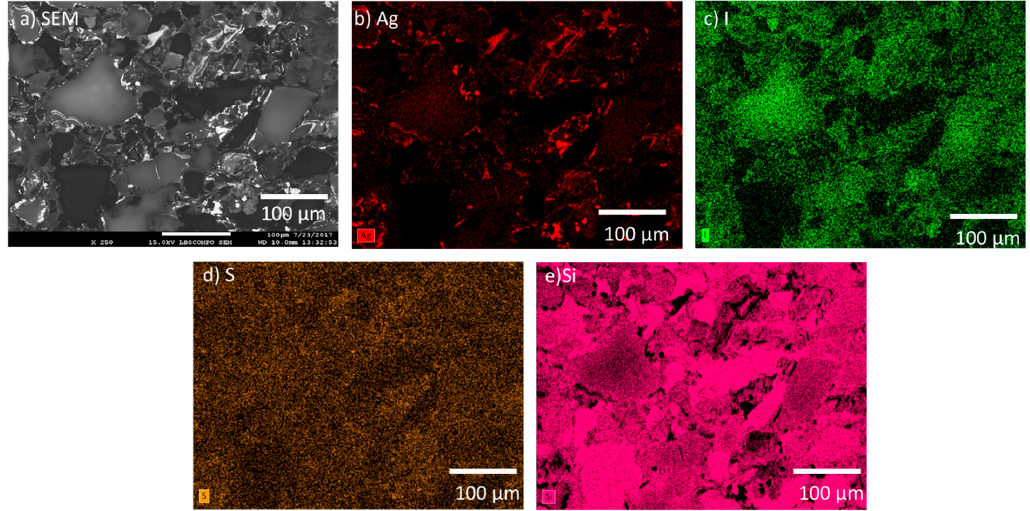
Figure 5. Microstructure of the SPS-1 sample shown by: ( a ) SEM micrograph; and the corresponding EDS maps of: ( b ) Ag; ( c ) I; ( d ) S; and ( e ) Si.